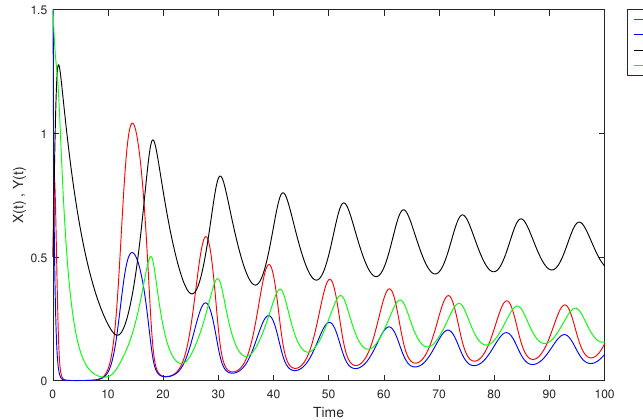
Figure 27. The solution of (13) at α = 0.0 as time